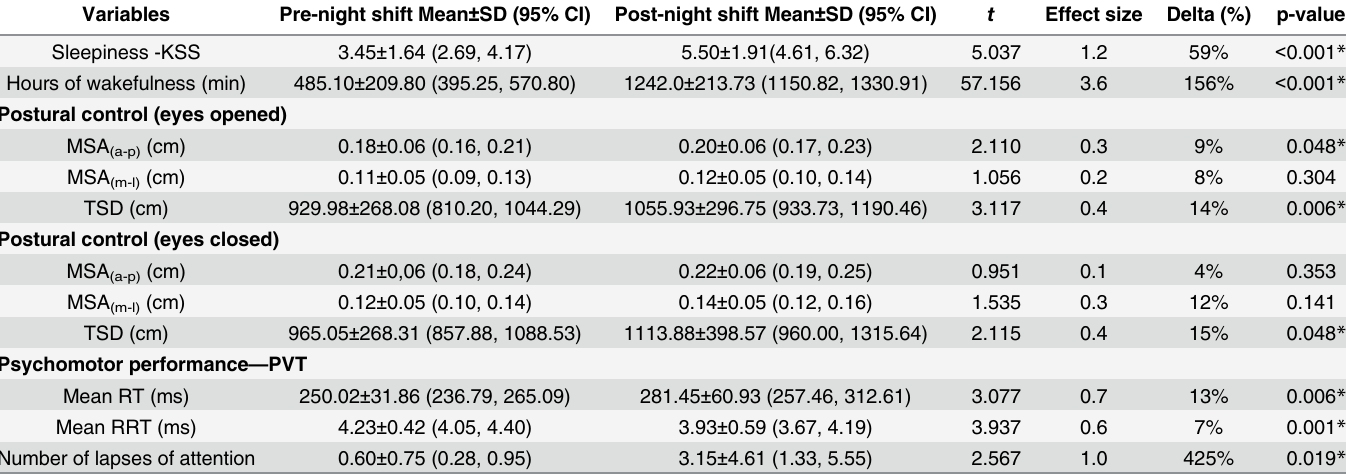
Table 1. Comparison of the variables related to postural control and psychomotor performance of night workers before and after the night work (n = 20). Variables